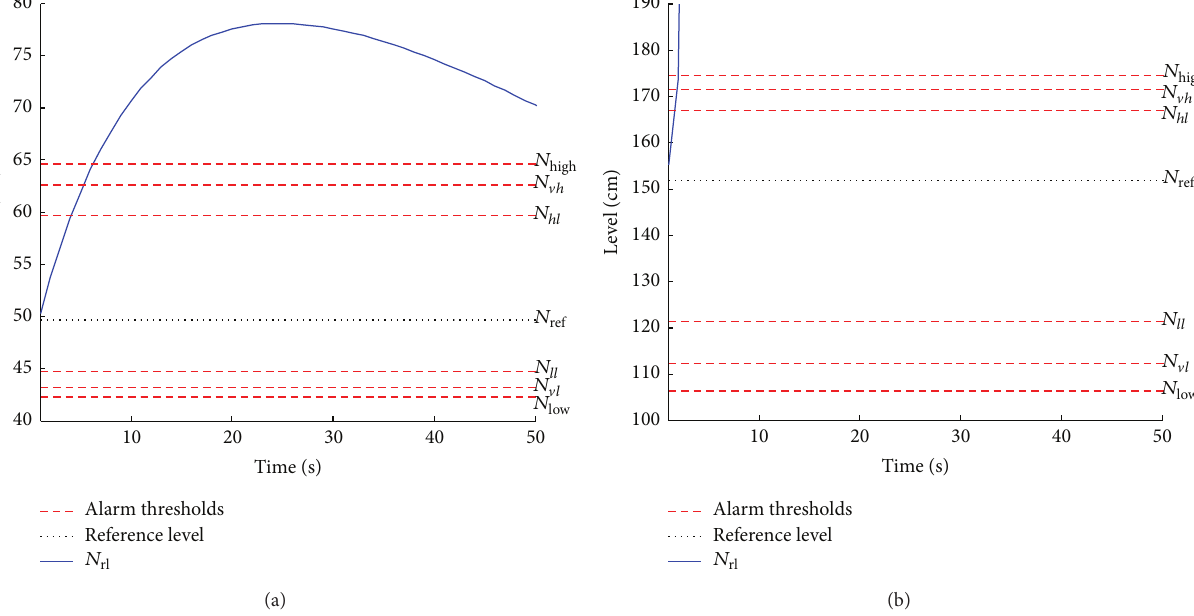
(MCS) with respect to the low and high level failure